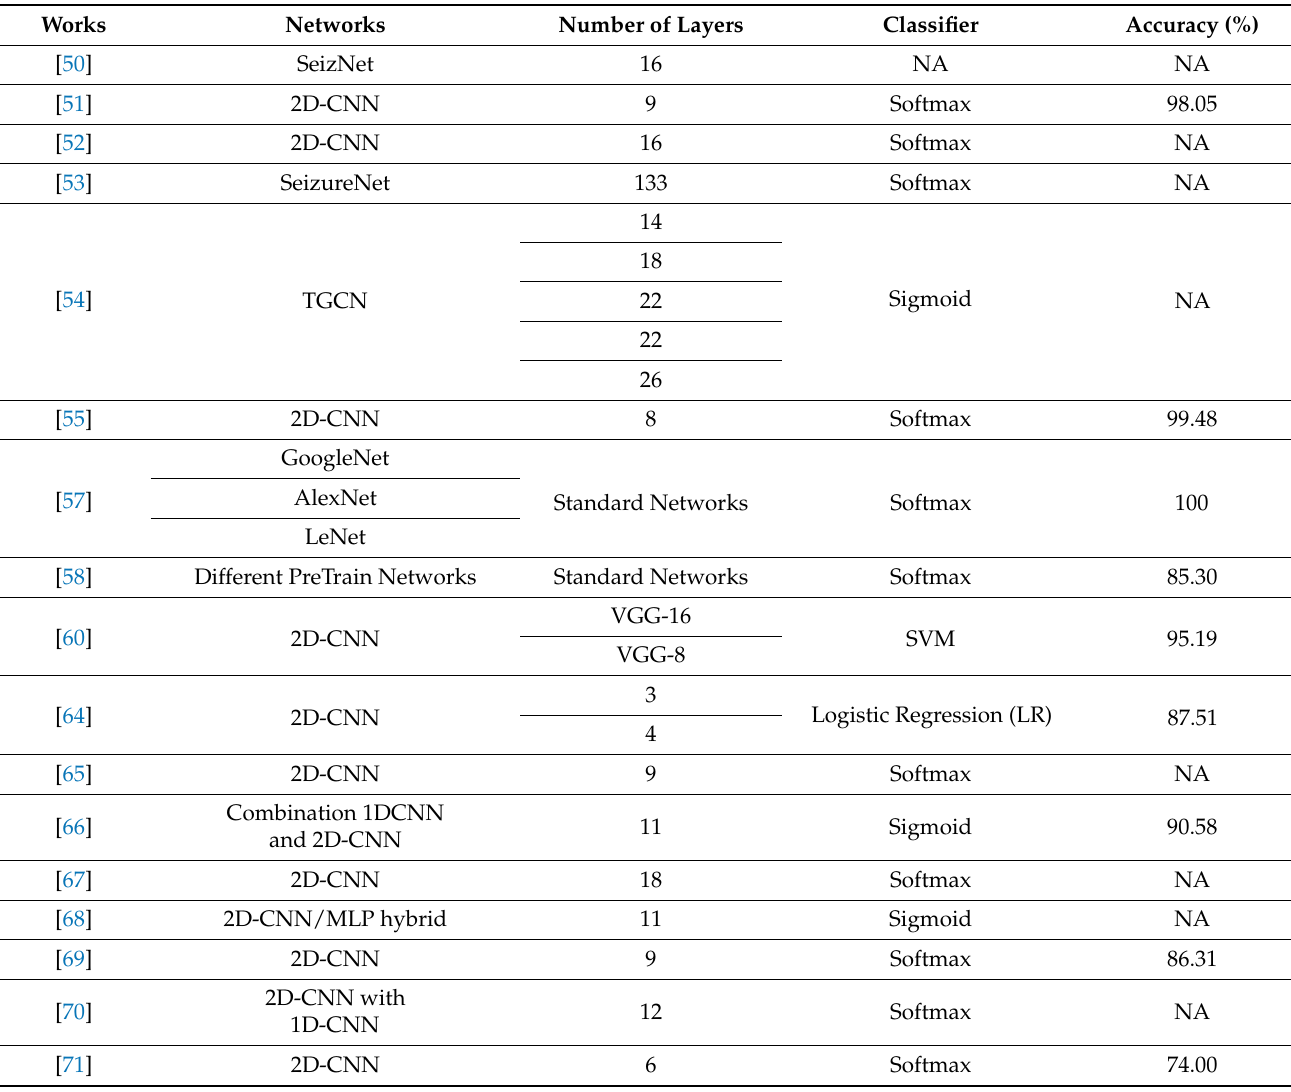
Table 2. Summary of related works done using